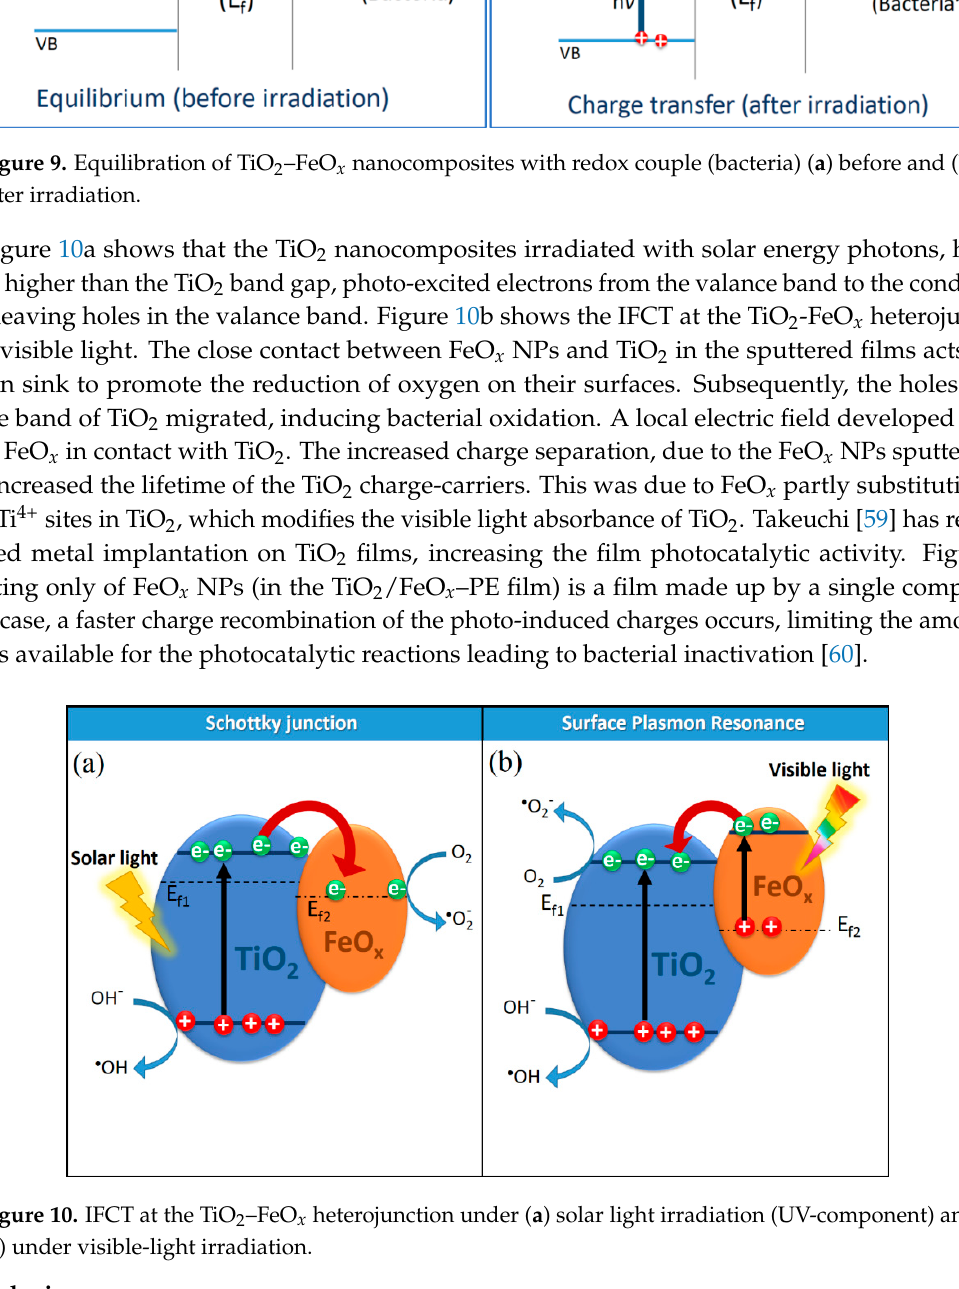
Figure 10. IFCT at the TiO 2 –FeO x heterojunction under ( a ) solar light irradiation (UV-component) and ( b ) under visible-light irradiation.